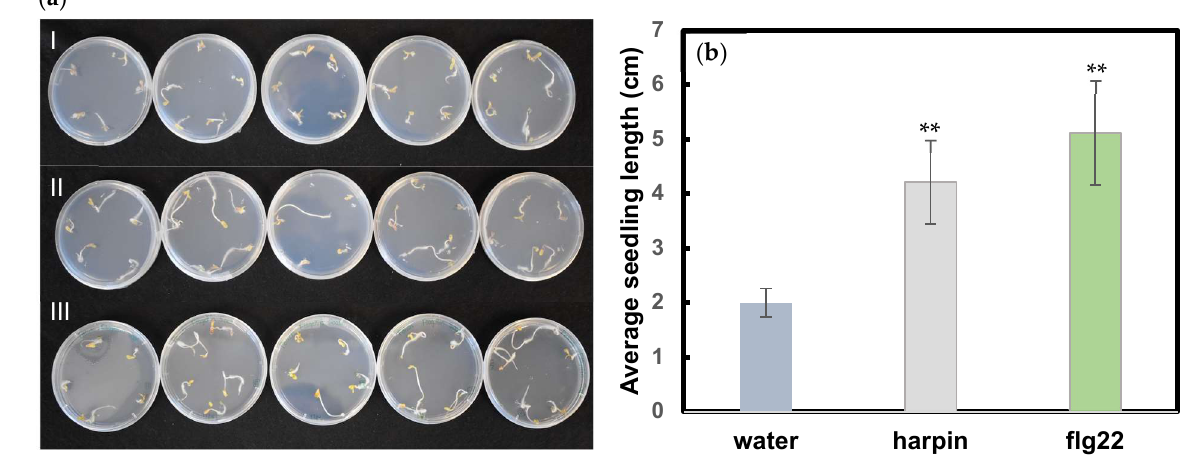
Figure 4. Enhancement of seedling growth by harpin and flg22. Experiments were conducted the same as shown in Figure 1 but without pathogen. ( a ) Growth of seedlings after 7 d on Petri plates with I, water agar, II, addition of harpin and III, addition of flg22. All five replicates for each treatment were shown. ( b ) Average seedling length. Statistically significant difference in comparison to water control was determined using Student t -test. ** indicates p ≤ 0.01.